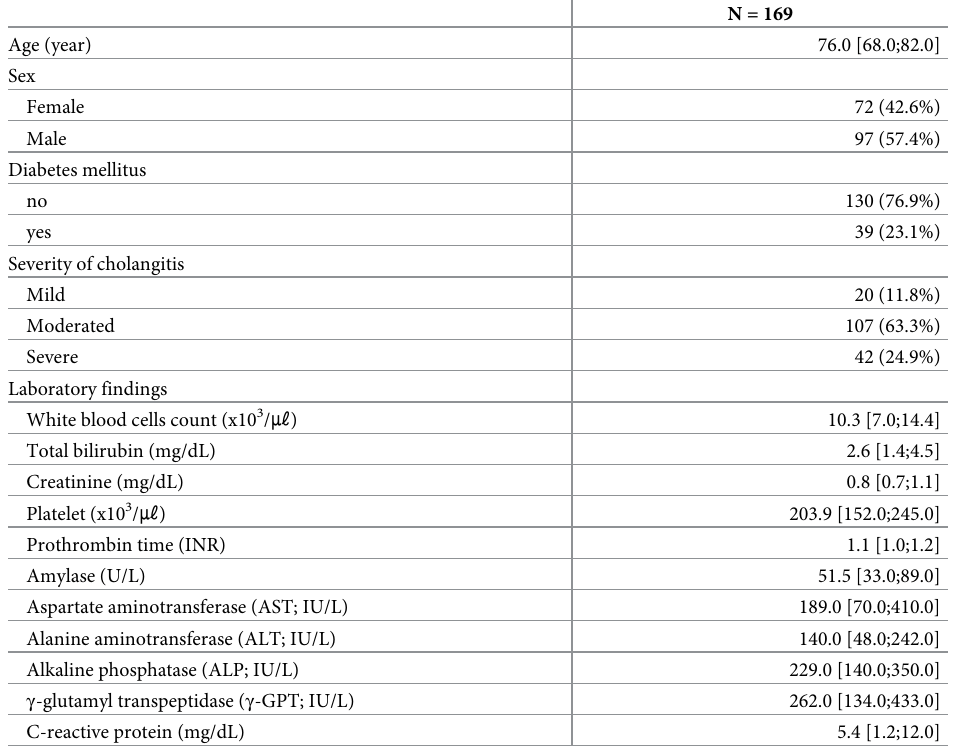
Table 2. The characteristics of clinical factors.